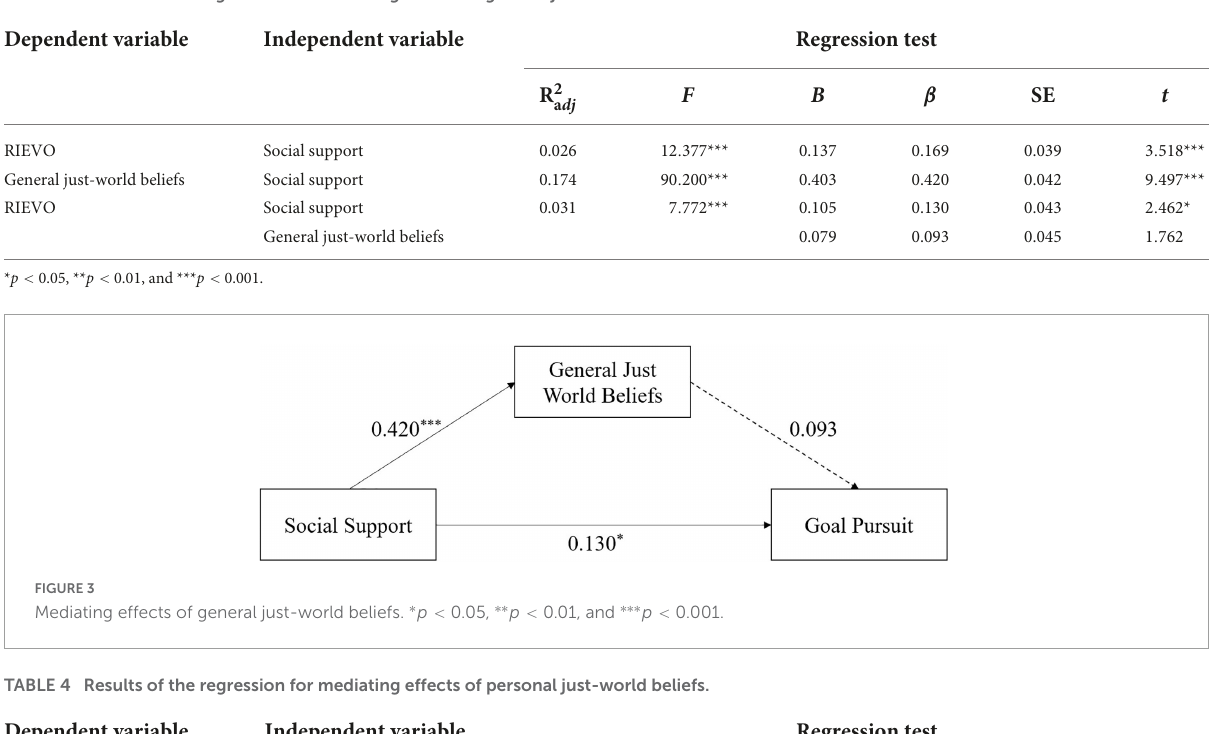
TABLE 3 Results of the regression for mediating effects of general just-world beliefs.